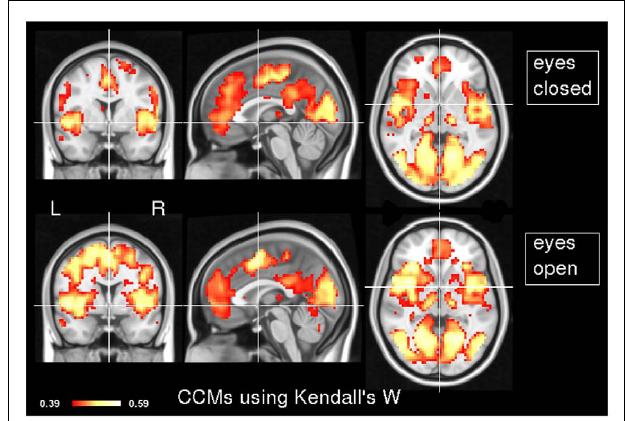
FIGURE 1 | Inter-subject CCM using Kendall’sW. CCM has been calculated for eyes-closed (top) and eyes-open (bottom), n = 7 subjects in each condition. MNI coordinates of slice positions are (0, 0, 0).The concordance measure was Kendall’sW.